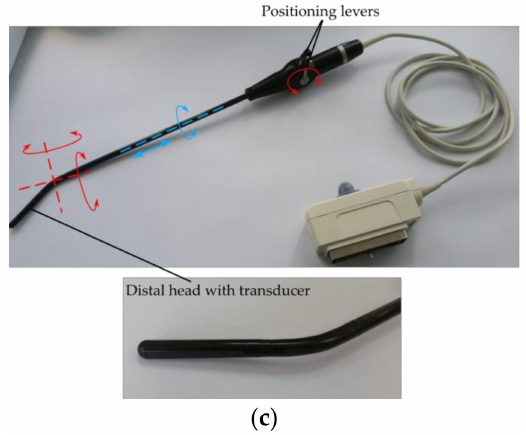
Figure 2. Automated instruments for the ProHep-LCT robotic system: ( a ) needle insertion instrument; ( b ) US probe manipulation instrument; ( c ) Hitachi Arieta intraoperatory US probe.